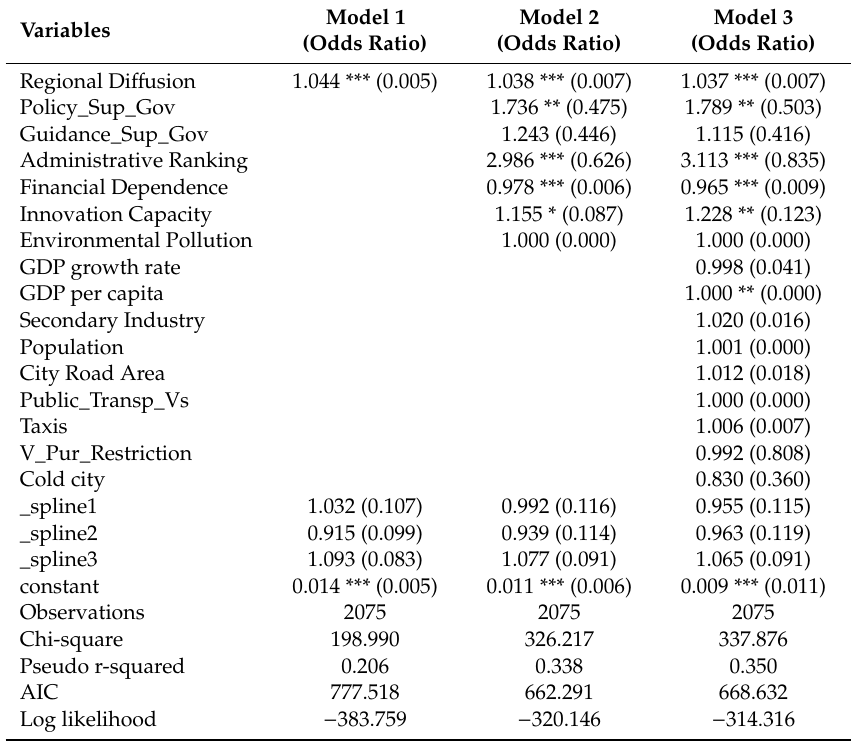
Table 4. Event history analyses of the di ff usion of local financial subsidies policy for NEVs a.